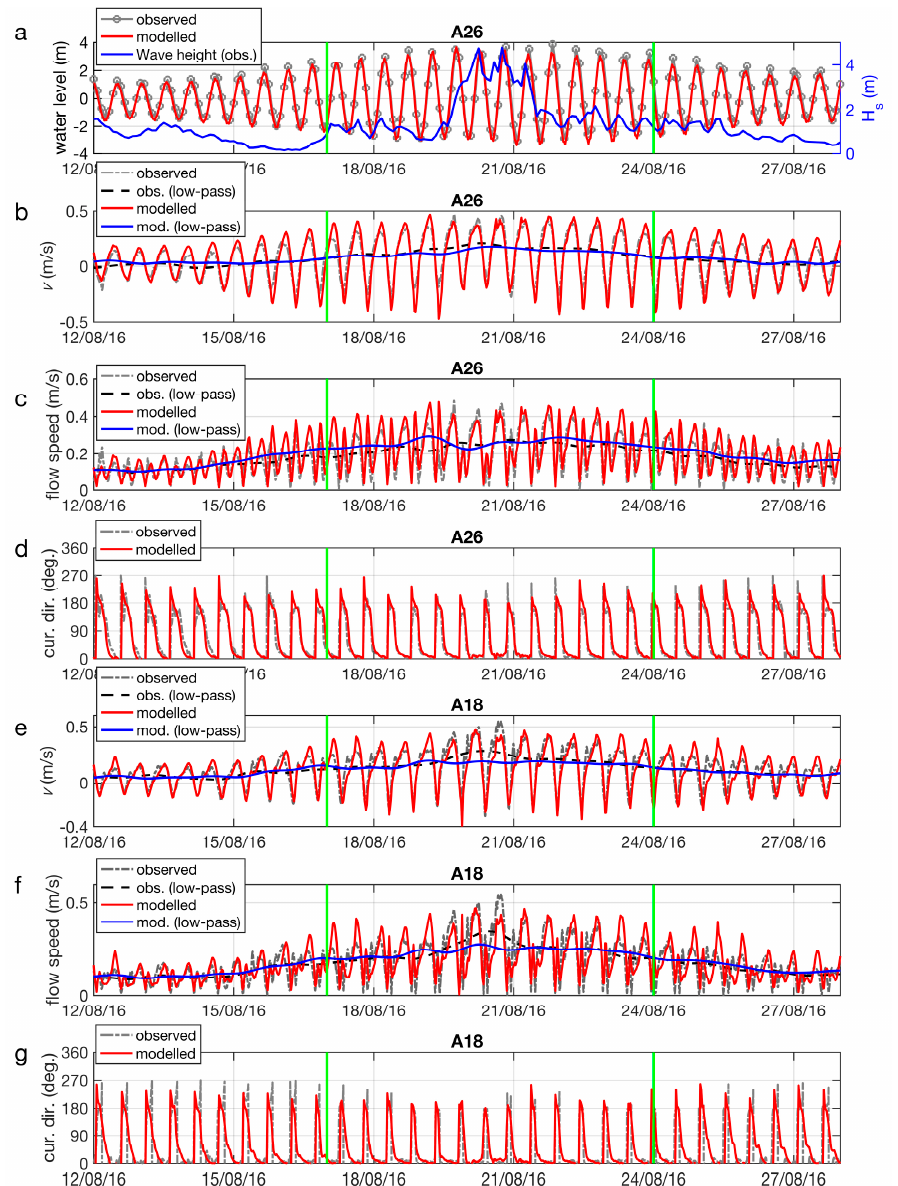
Figure 4. ADCP (A26, A18) water level and flow velocity observations compared with FLOW model output, including the following: water level comparison for A26, with wave height indicated ( a ); northward current, flow speed, and direction for A26 ( b – d ); and northward current, flow speed, and direction for A18 ( e – g ). The observed water levels (120-min) are spline interpolated to the FLOW time-step (30-min). The observed and modelled current speed and direction are 30-min averages. Low-pass current speed has a Fourier transform filter applied, with a 25-h cut-off. Vertical green lines indicated the 1-week calibration period.